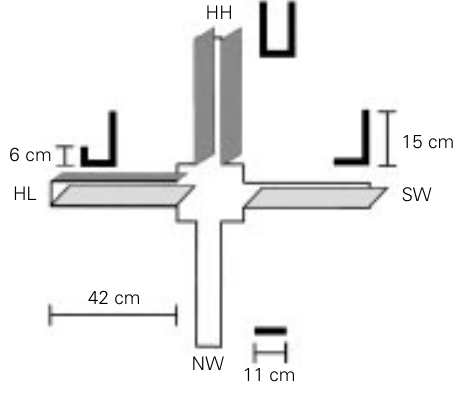
Figure 1 - Simplified diagram of the elevated asymmetric plus- maze. NW = No wall arm; SW = single wall arm; HL = high and low wall arm; HH = two high wall arm. Animals were placed in the central platform at the be- ginning of the test. See text for